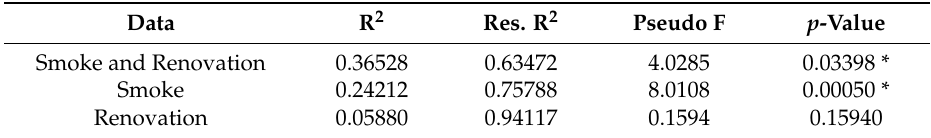
Table 4. Results of permutational multivariate analysis of variance.